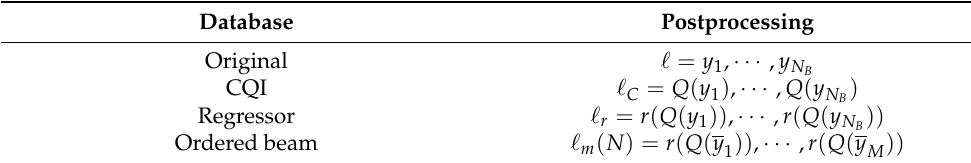
Table 1. Database and